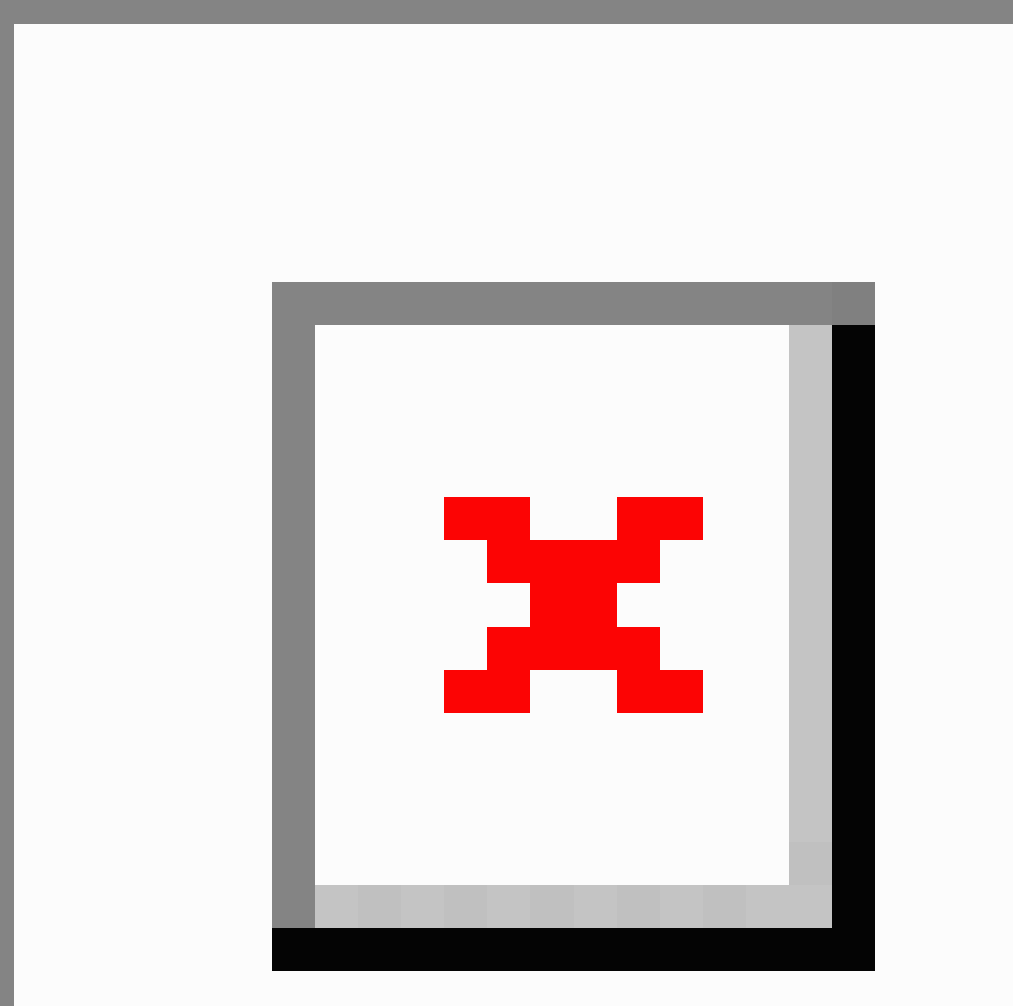
Figure 4. Distribution of 24-hour moderate-to-vigorous physical activity (MVPA) for 2046